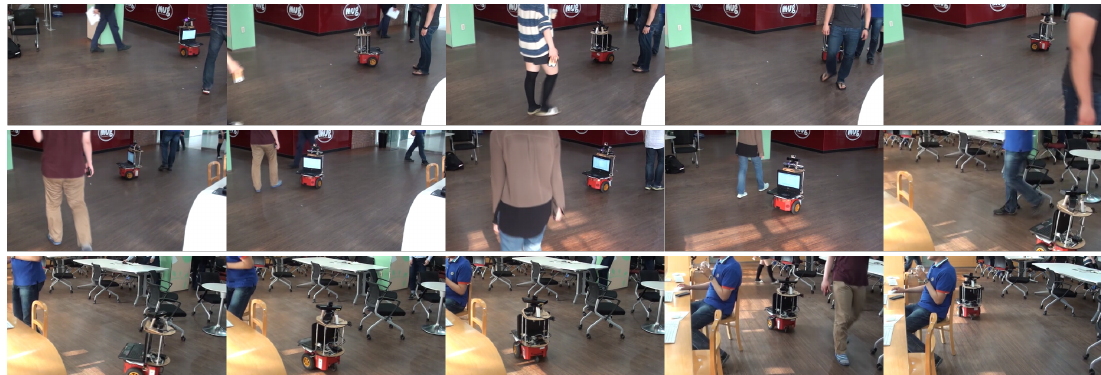
Figure 12. Snapshots from a real autonomous robot navigation experiment using the proposed motion model and motion controller in a school